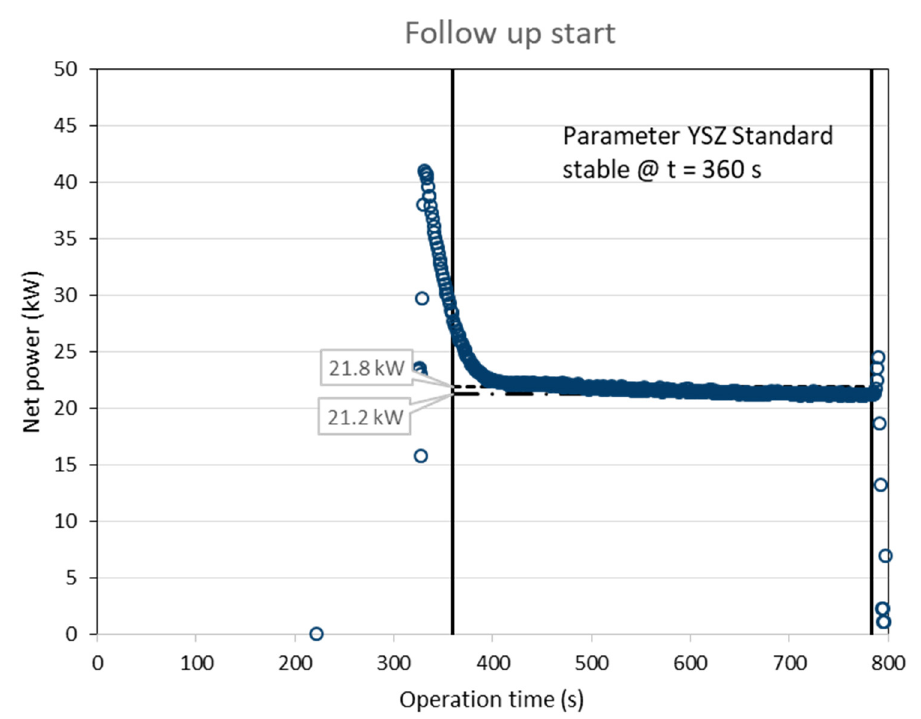
Figure 4. Time course of the torch net power calculated from the torch input power and the power dissipated to the water cooling (follow up start of the gun); stable plasma conditions were indicated by the controller at t = 360 s.